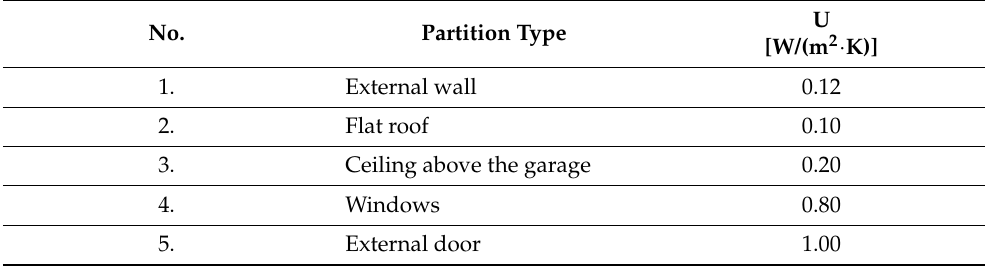
Table 4. Heat transfer coefficients U for buildings with passive energy characteristics